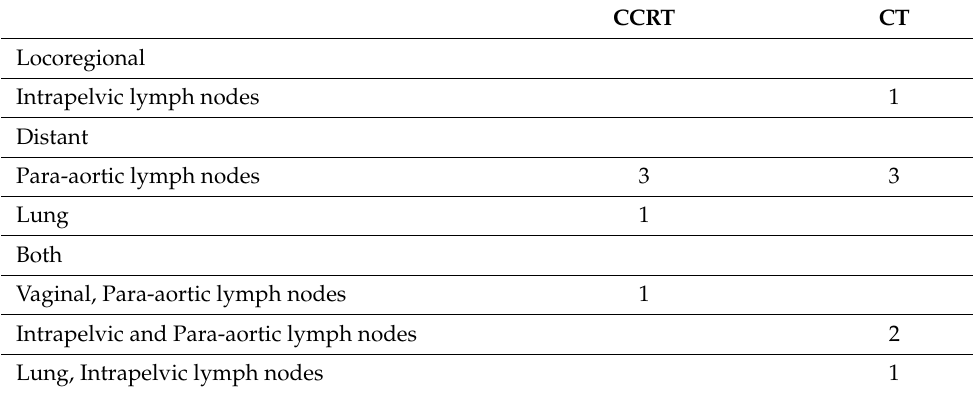
Table 2. Site of recurrence.